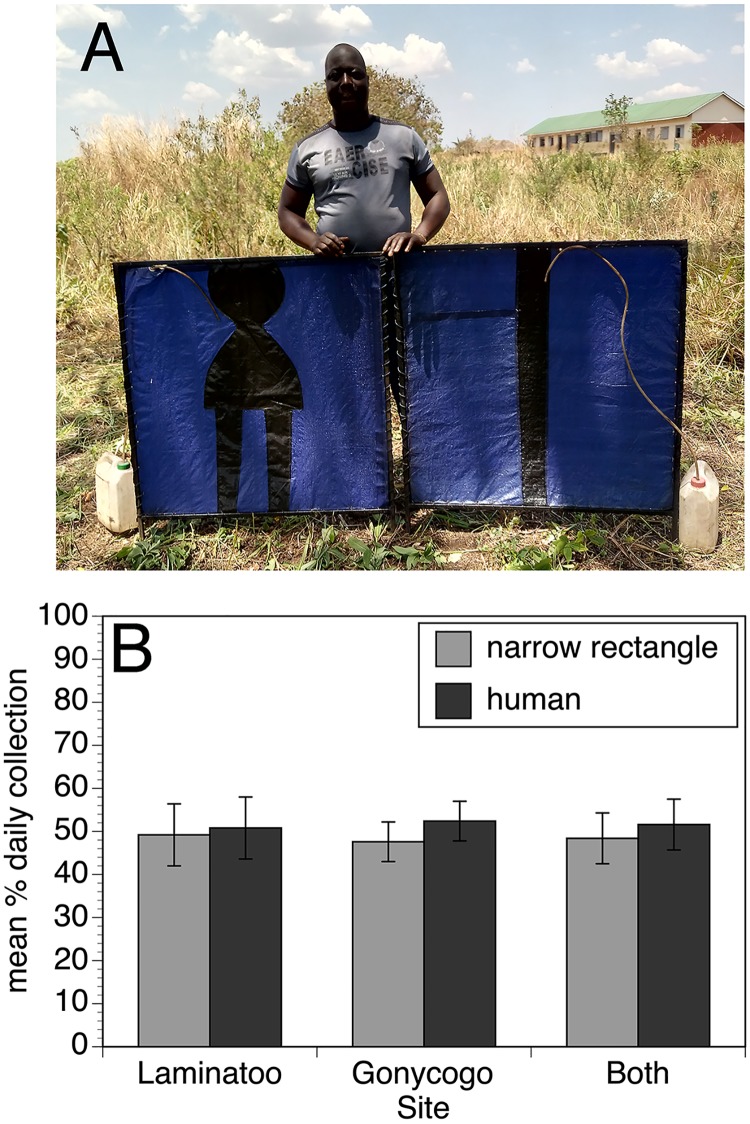
Relative performance of simple and human shaped stripe designs.Panel A: Photograph of the simple narrow stripe and human shaped stripe trap designs. Panel B: Relative performance of the simple narrow stripe and human shaped stripe trap designs in Laminatoo, Gonycogo and data from both communities combined. Data are presented as the mean percentage of the total collection by day, normalizing for variations in the absolute number of flies collected on each day, as described in Materials and Methods. Error bars indicate the standard deviation associated with the means. The analysis was conducted on data collected from 30 paired trials each in Laminatoo and Gonycogo. Raw collection data for this study may be found in the S4 Table.